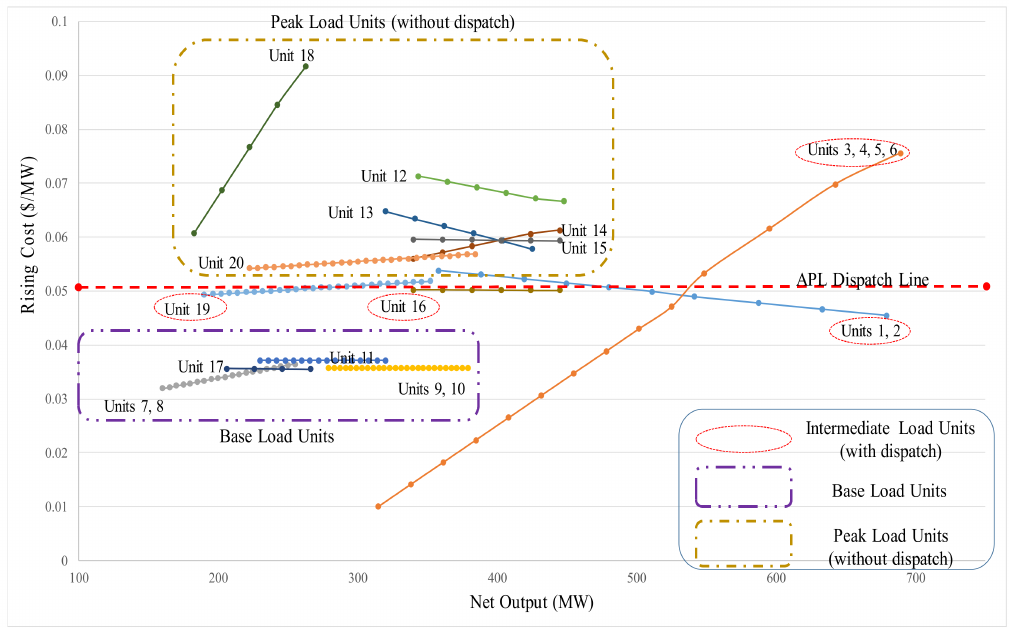
Figure 2. Ramp-up cost of the 20 natural gas combined-cycle units provided by Taiwan Power Company within 30 min.